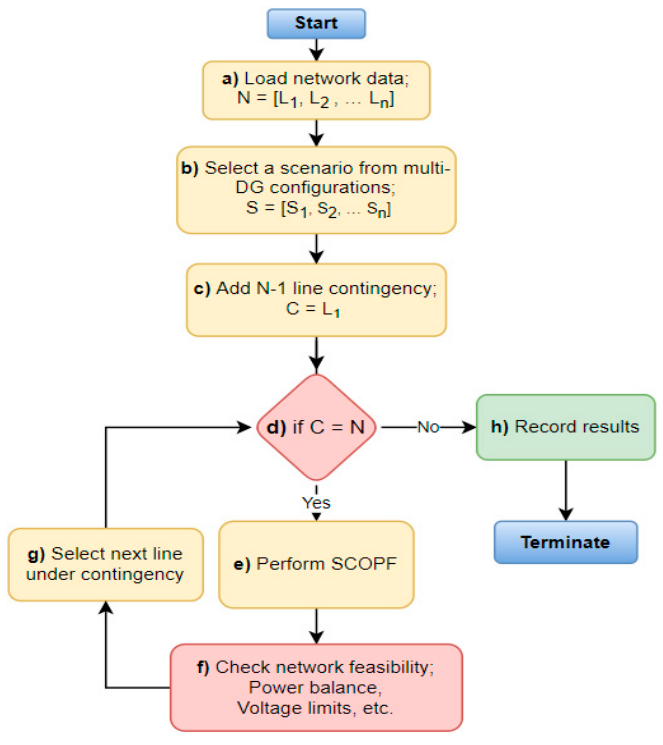
Figure 1. Flowchart of the proposed method for N-1 line contingency analysis.